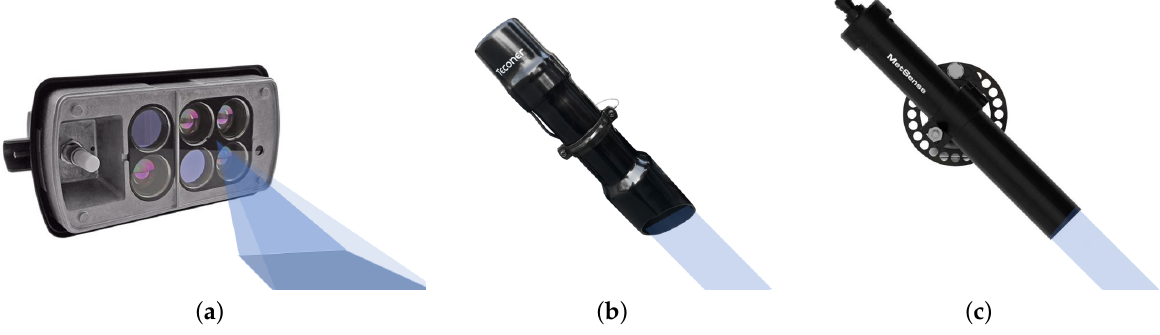
Figure 9. ( a ) MARWIS-UMB RSC sensor from LUFFT (Germany) [28], ( b ) RCM411™ intelligent optical RSC patrol system from Teconer (Finland) [29], and ( c ) MetRoad from MetSense (Sweden) [30]. Table 4. Comparison of typical vehicle-mounted RSC detection product parameters. LUFFT MARWIS-UMB